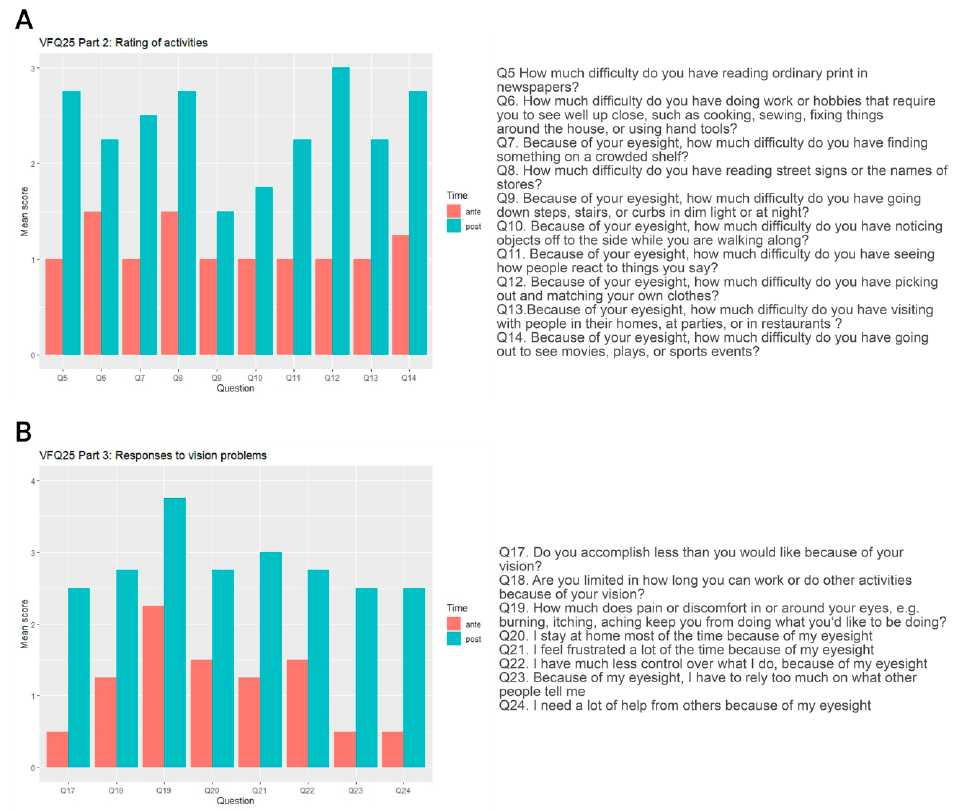
Figure 5. Vision-related behavioral and psychometric changes after gene therapy. ( A , B ) show the reported responses to questions of the VFQ25 on certain activities that require good eyesight ( A ) and to questions about things whose performance may be affected by vision ( B ). Responses before therapy (ante) are represented by red columns, whereas the turquoise columns represent responses given 6 months after gene therapy (post). Individual scores for each patient and item ranged from 0 (representing the worst possible answer) to 4 (most positive answer as one would expect from a normally sighted person). Illustrated are the mean scores of each item for P1-P4 ( n = 4). All items showed a clear increase in score and thus an improvement of the visual ability was reported by all patients and their parents, respectively.